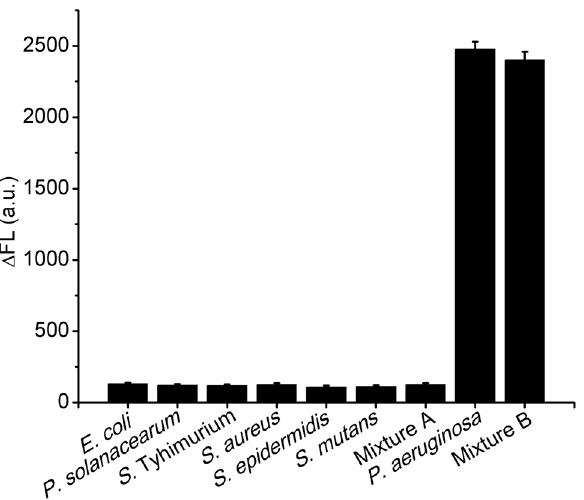
Figure 4. Specificity of RAP for P. aeruginosa detection. The concentrations of all the tested bacteria were 1.0 × 10 5 CFU ⋅ mL −1 ( n = 4).